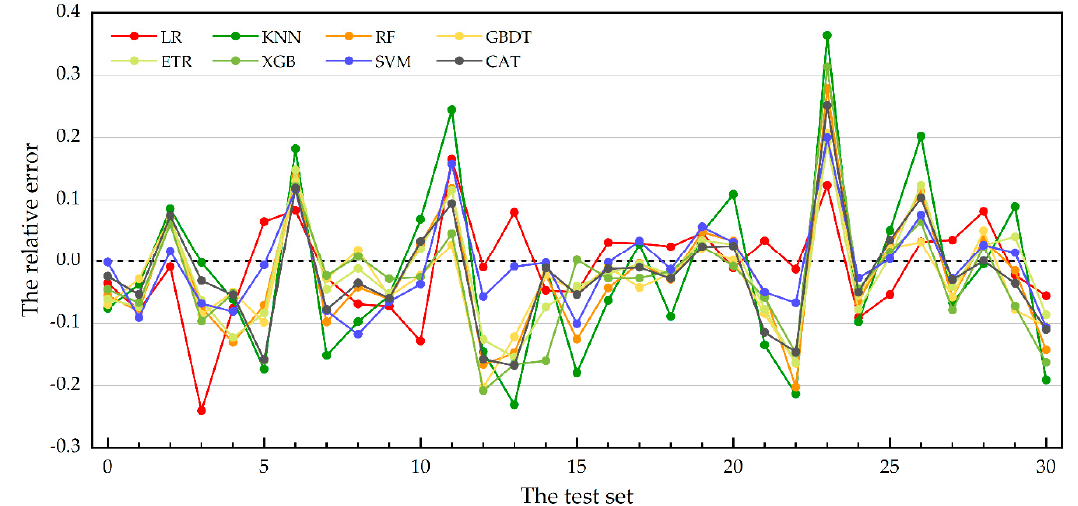
Figure 9. Relative error of prediction of each single model: The error between the predicted value and the actual value of each model.